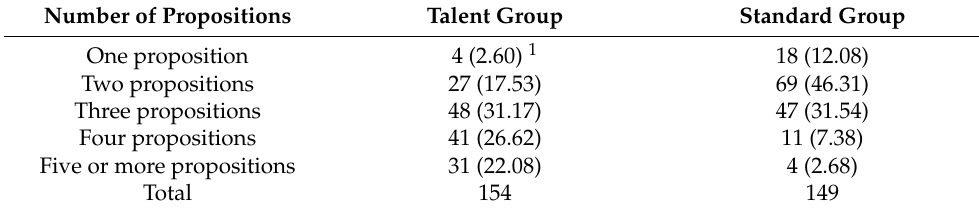
Table 1. Number of dissimilar